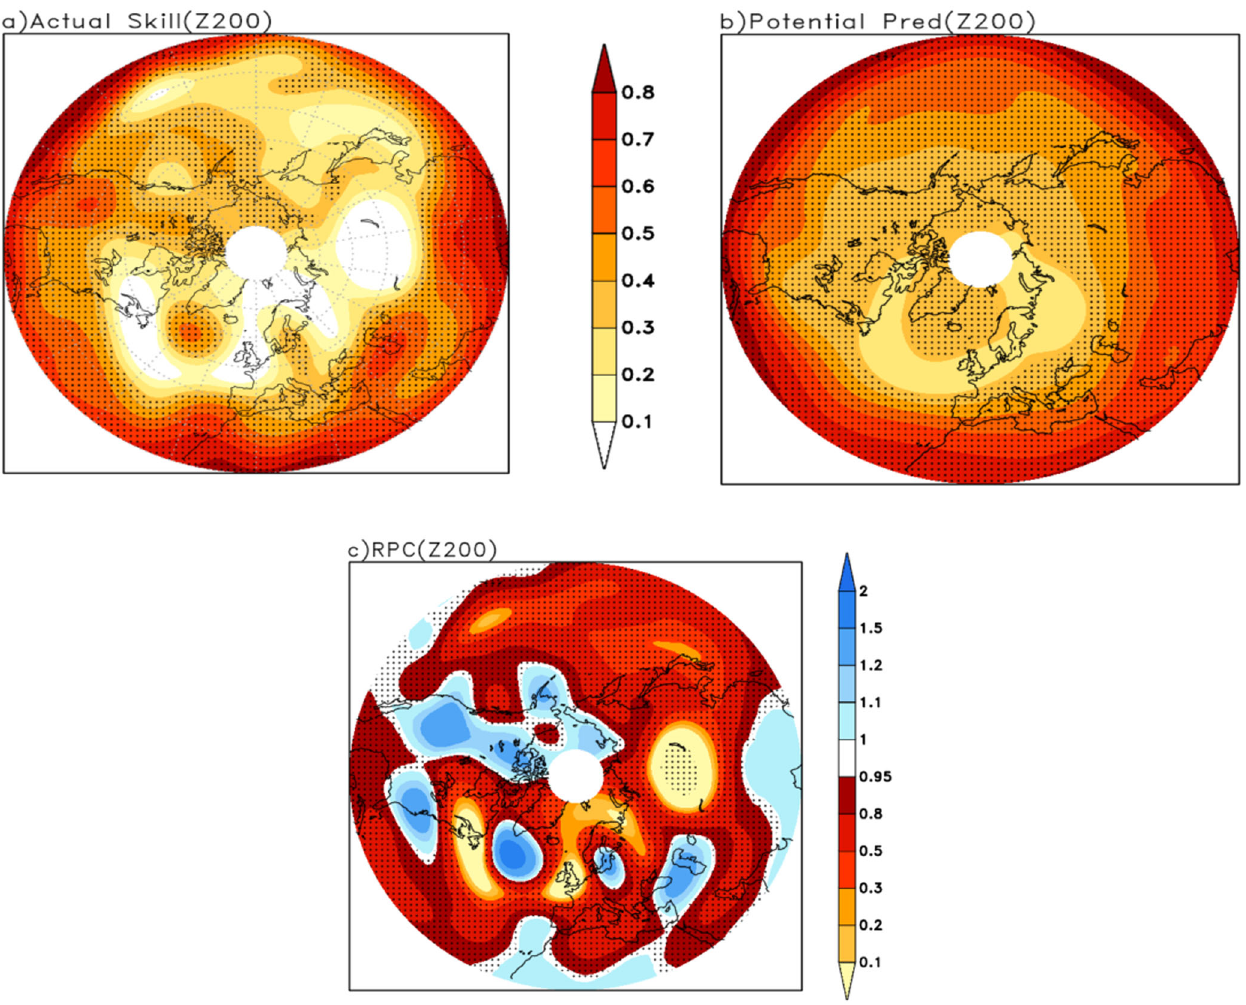
Fig. 6 Predictability of the North Atlantic European circulation anomalies. a Actual prediction skill of the early winter (November – December; ND) 200-hPa geopotential height anomalies (Z200) over the North Atlantic European (NAE) region; ( b ) Potential Predictability of the 200-hPa geopotential height anomalies over NAE region; ( c ) Ratio of the Predictable Component (RPC), where RPC > 1 shows under con fi dence behavior of the model (blue), while RPC < 1 is the overcon fi dent behavior (red). Stippling denotes the statistical signi fi cance at 95% con fi dence